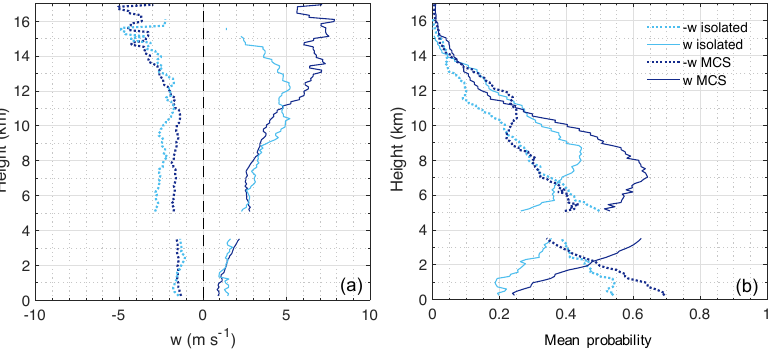
Figure 6. (a) Mean vertical velocity profiles for MCSs and isolated cells for downdrafts ( w <0ms − 1 ; dashed) and updrafts ( w >0ms − 1 ; solid). (b) Mean probability of observing updrafts or downdrafts as a function of altitude. Means are composited from data within 30min of largest drop in (cid:49)θ e (0–0.5h in Figs. 4 and 5).